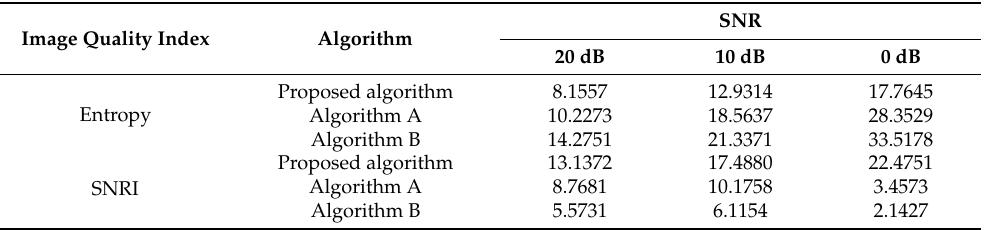
Table 3. Experimental Results under different SNRs of measured